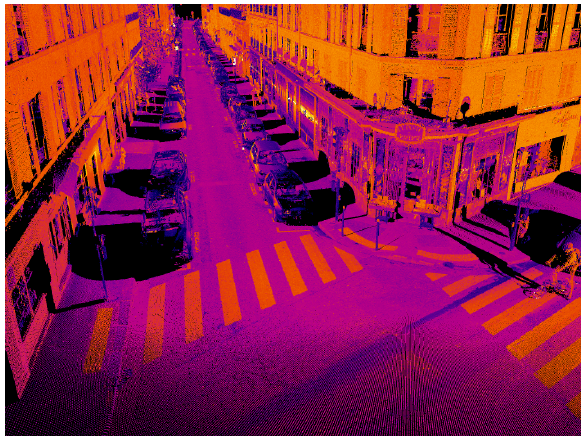
Figure 1: Full ortho/DTM production pipeline from MLS. Framed rectangles are processing steps, unframed rectangles are